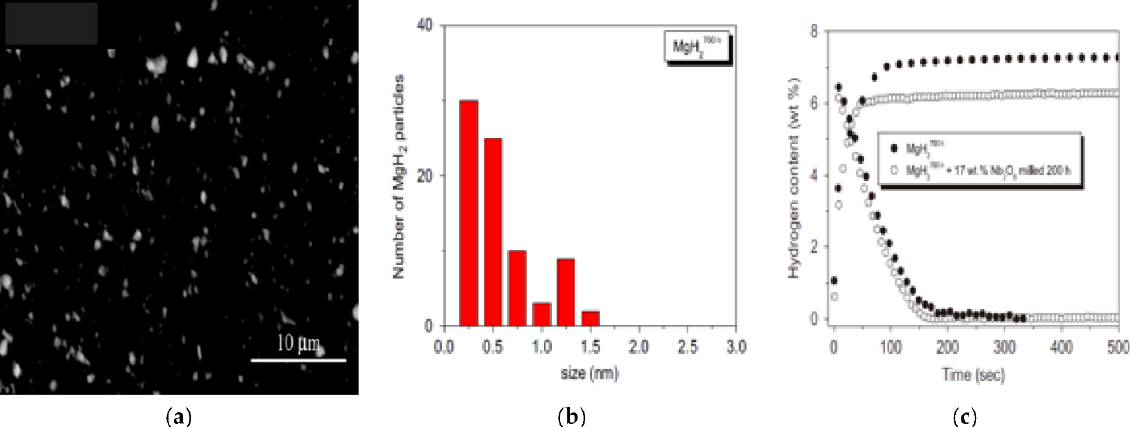
Figure 43. ( a ) SEM backscattered electron image of MgH 2 700 h . ( b ) distribution of MgH 2 700 h particle size determined by the analysis of the SEM image. ( c ) Absorption and desorption curves of MgH 2 700 h and MgH 2 700 h + Nb 2 O 5 milled together for 200 h. ( a – c ) Reproduced with permission [306]. Copyright 2006,